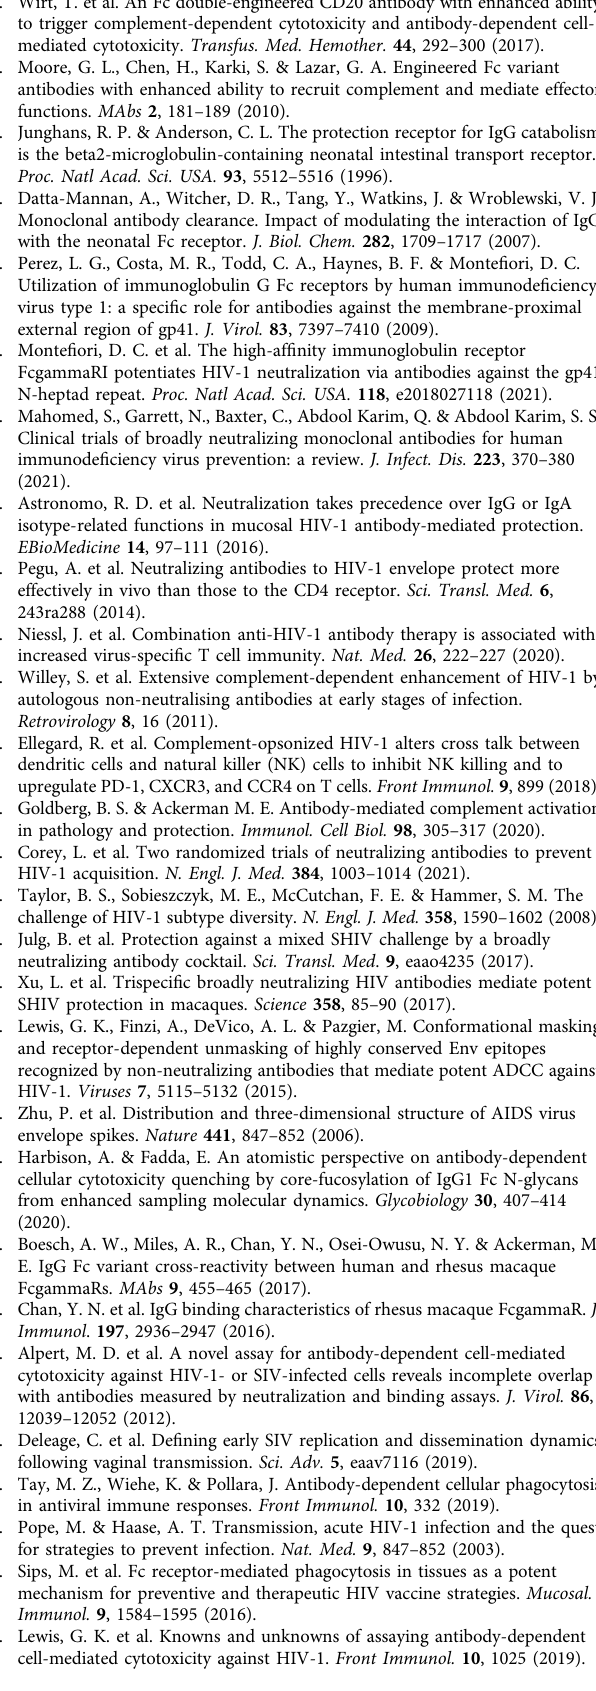
Fig. 4m were analyzed by two-way repeated-measures ANOVA followed by Tukey ’ s post-hoc test for multiple comparisons. Correlation plots in Figs. 6b, d,